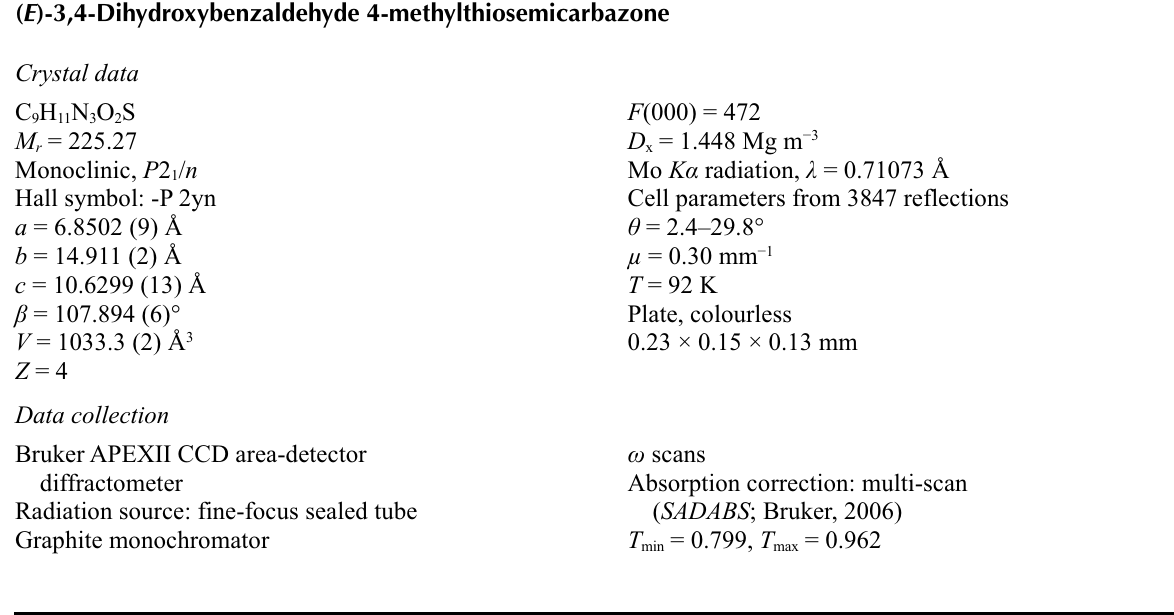
Figure 2 Crystal packing of (I) viewed down the c axis with hydrogen bonds drawn as dashed lines. H-atoms not involved in H- bonding have been